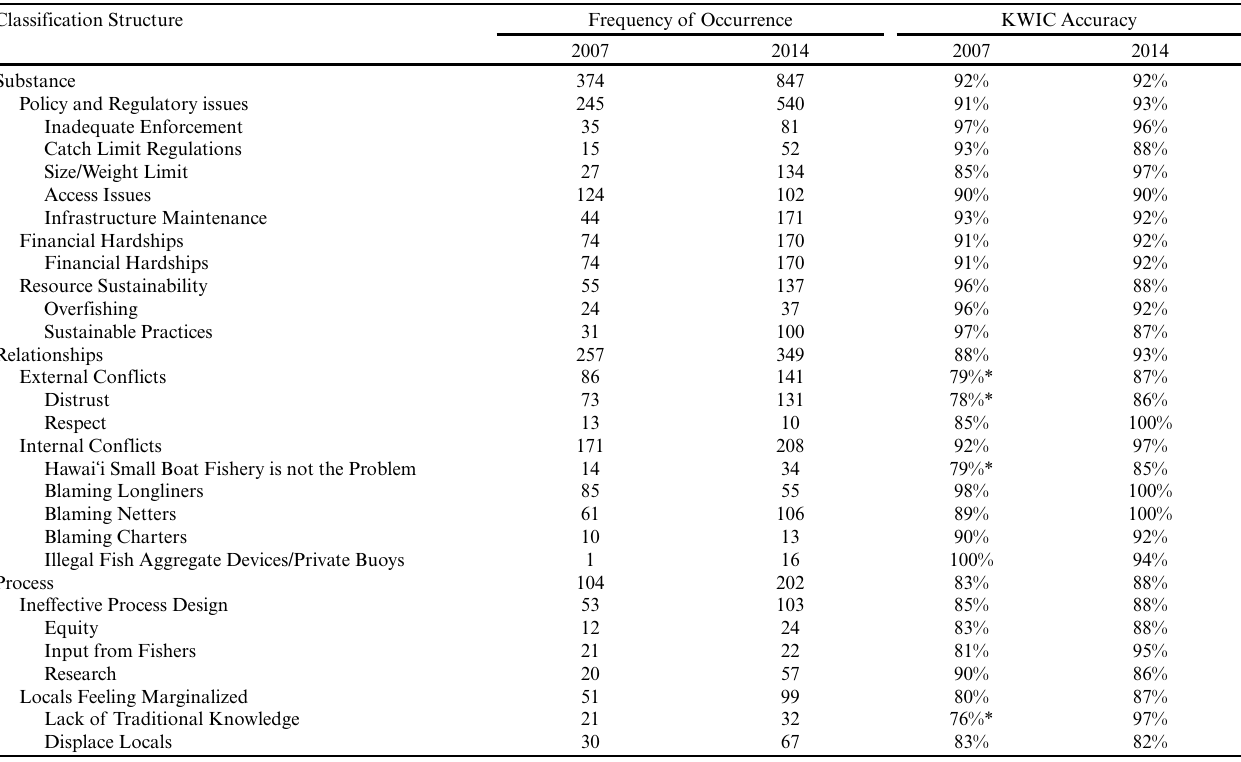
Table 3 . Analysis of automated content analysis (ACA) accuracy. The frequency of occurrence is the number of times the keywords in each code occurred in the dataset for 2007 and 2014. The keyword in context tool (KWIC) accuracy is the proportion of times a keyword was accurately classified into the appropriate coding structure over the total occurrences. * indicates unsatisfactory validity where less than 80% of occurrences were correctly